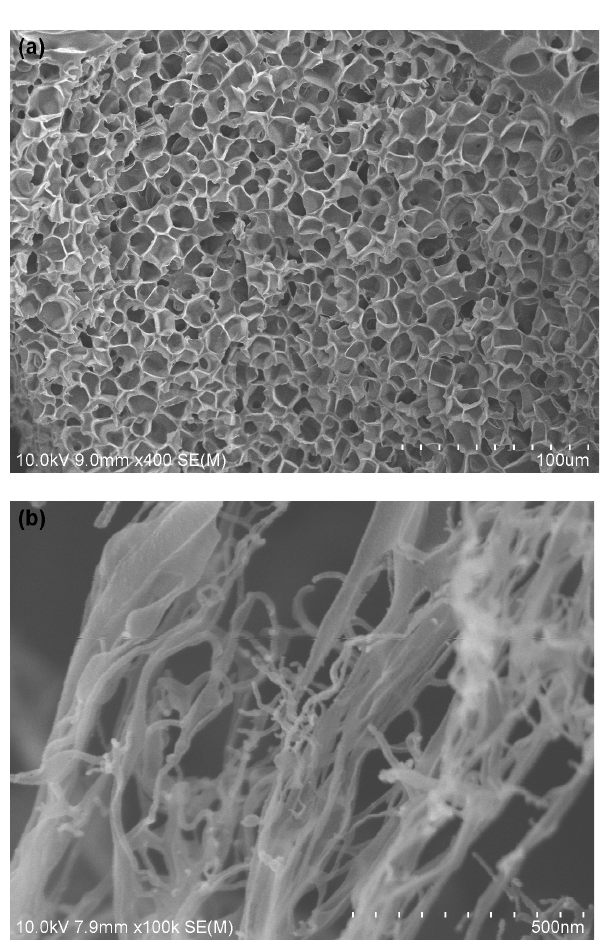
Figure 1: SEM micrographs of the PAAm-MWNTs hybrid hydrogel (0.2 wt.% MWNTs) with 82 wt.% water (a) and swelled to an equilibrium state